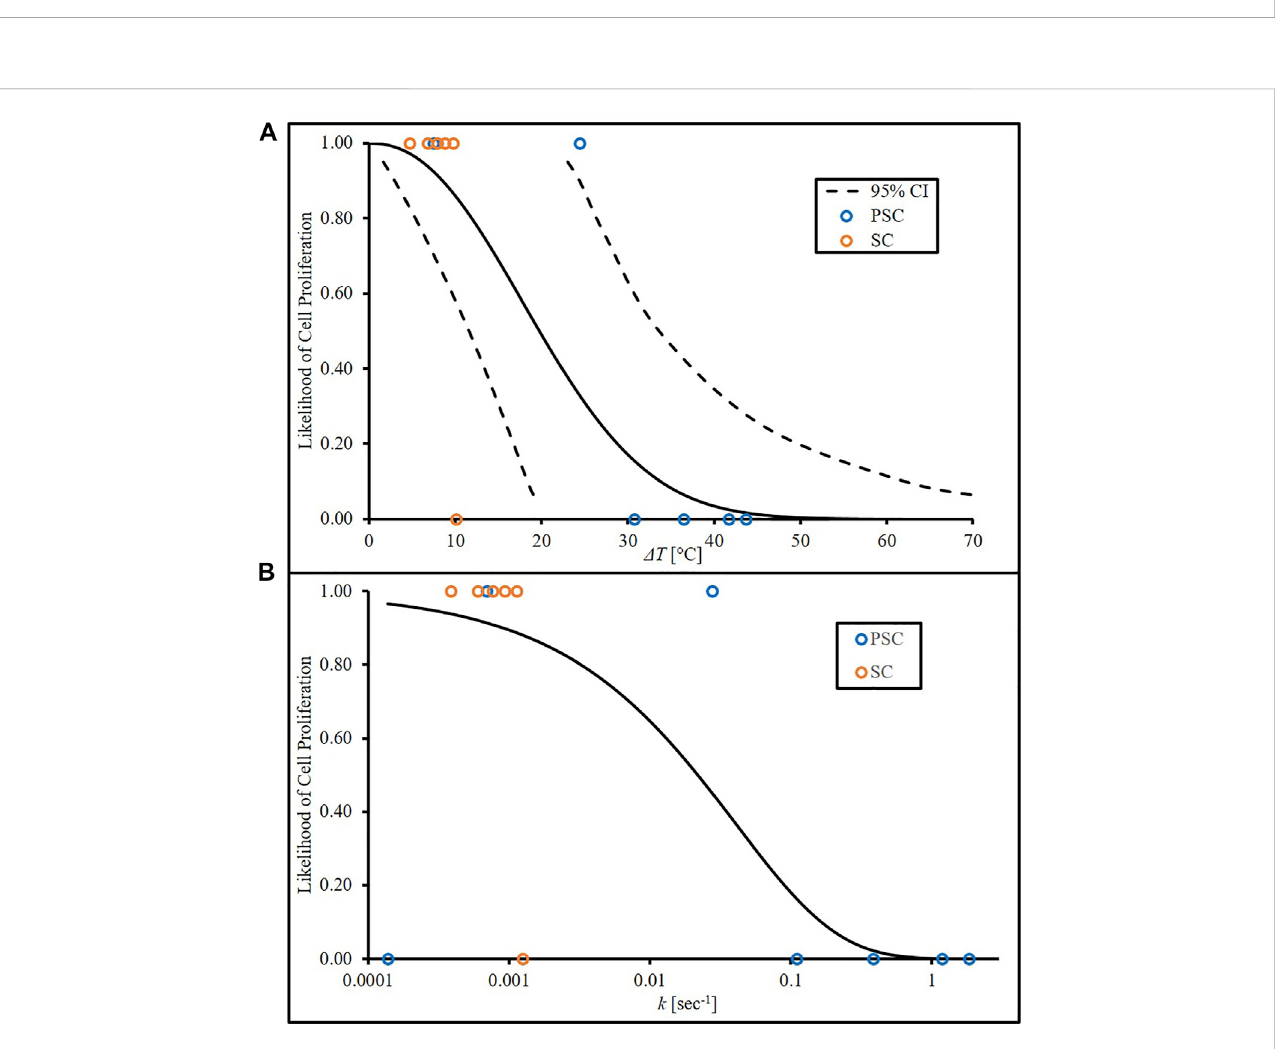
FIGURE 3 Likelihood of cell proliferation curves from (A) temperature increase based on experimental data with lower and upper bounds of a 95% CI and (B) cell death rate, k , derived from experimental temperature data and van Asselt and Zwietering model.